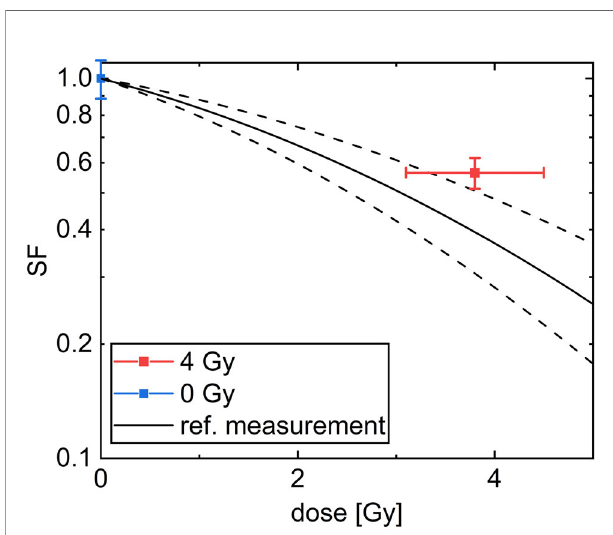
FIGURE 8 | Cell survival curve of CHO-K1 cells obtained after irradiation with 20 MeV protons. The black line denotes a common linear quadratic fi t to reference measurements with x-rays with a = (0.156 ± 0.045) 1/Gy and b = (0.0235 ± 0.0055) 1/Gy 2 . The dashed lines indicate the uncertainty range of the fi t. The mean over all samples irradiated with a dose of 4 Gy is indicated in red and the mean over the sham samples is indicated in blue. The dose error is the standard error of the mean of the irradiated doses and the SF error is obtained as described in the Methods section.